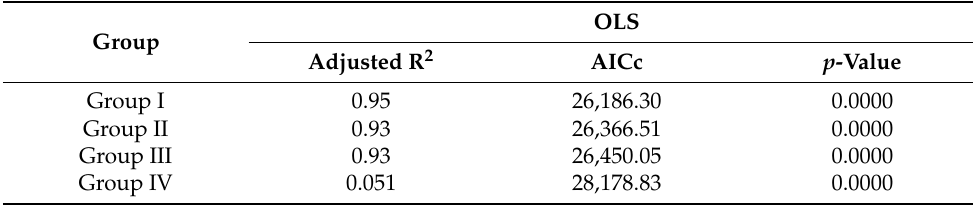
Table 6. Statistical correlation and OLS used on the groups.